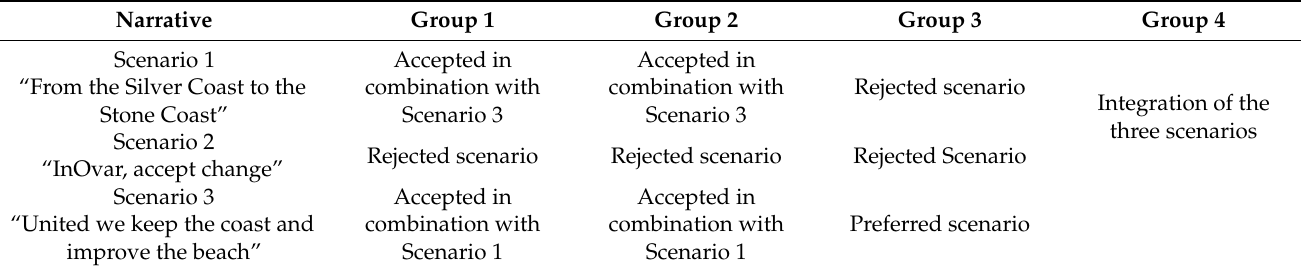
Table 6. Results of the analysis of all narratives by each of the four